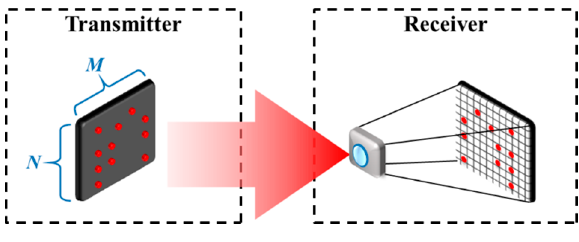
Figure 26. A visual MIMO scheme.